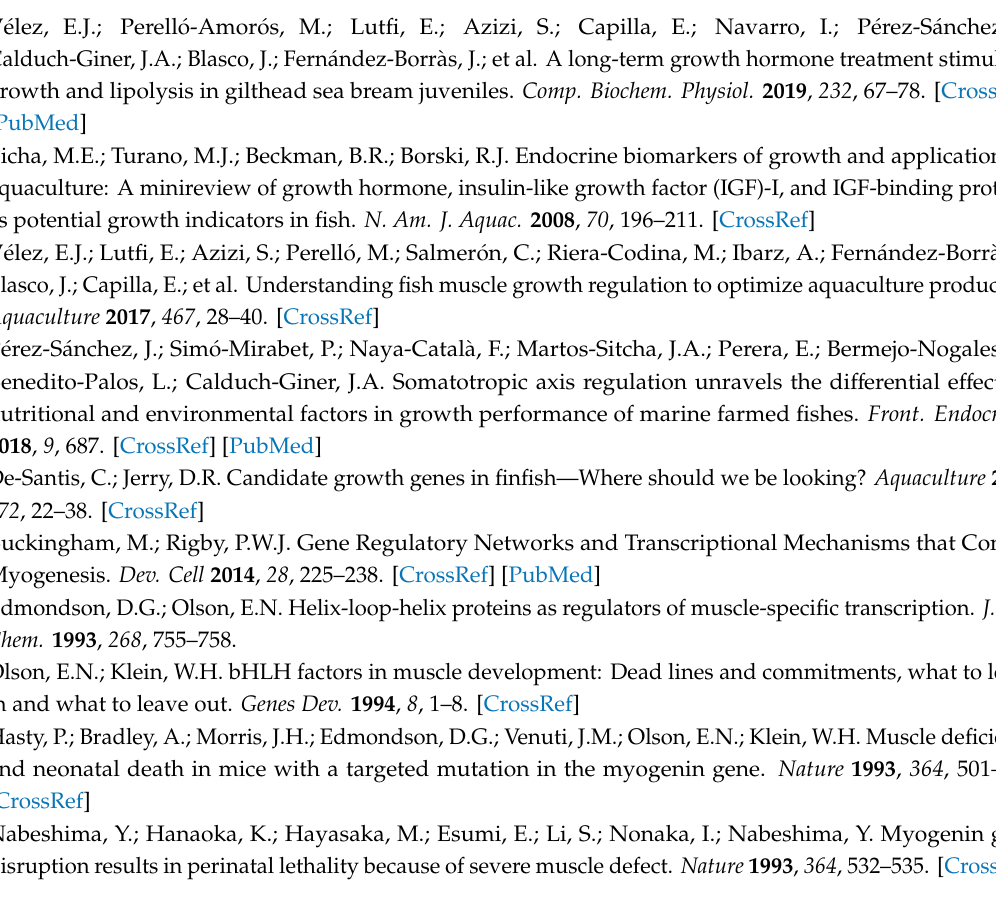
Figure S1: alignment of MSTN sequences, Figure S2: alignment of MyoG sequences, Figure S3: phylogenetic analysis of MSTN sequences, Figure S4: phylogenetic analysis of MyoG sequences, Figure S5: liver data for correlation analysis, Figure S6: muscle data for correlation analysis, Figure S7: adipose tissue data for correlation